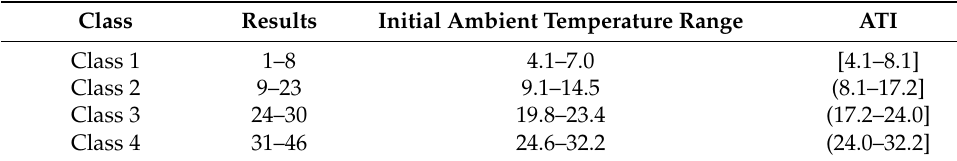
Table 5. Clustering results with four